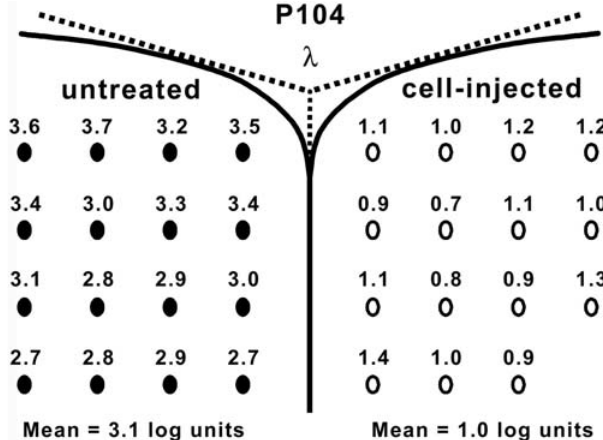
spatial visual acuity than untreated eyes (0.22 6 0.03 c/d vs. 0.14 6 0.02 c/d, p , 0.05), as shown previously. However, cell-